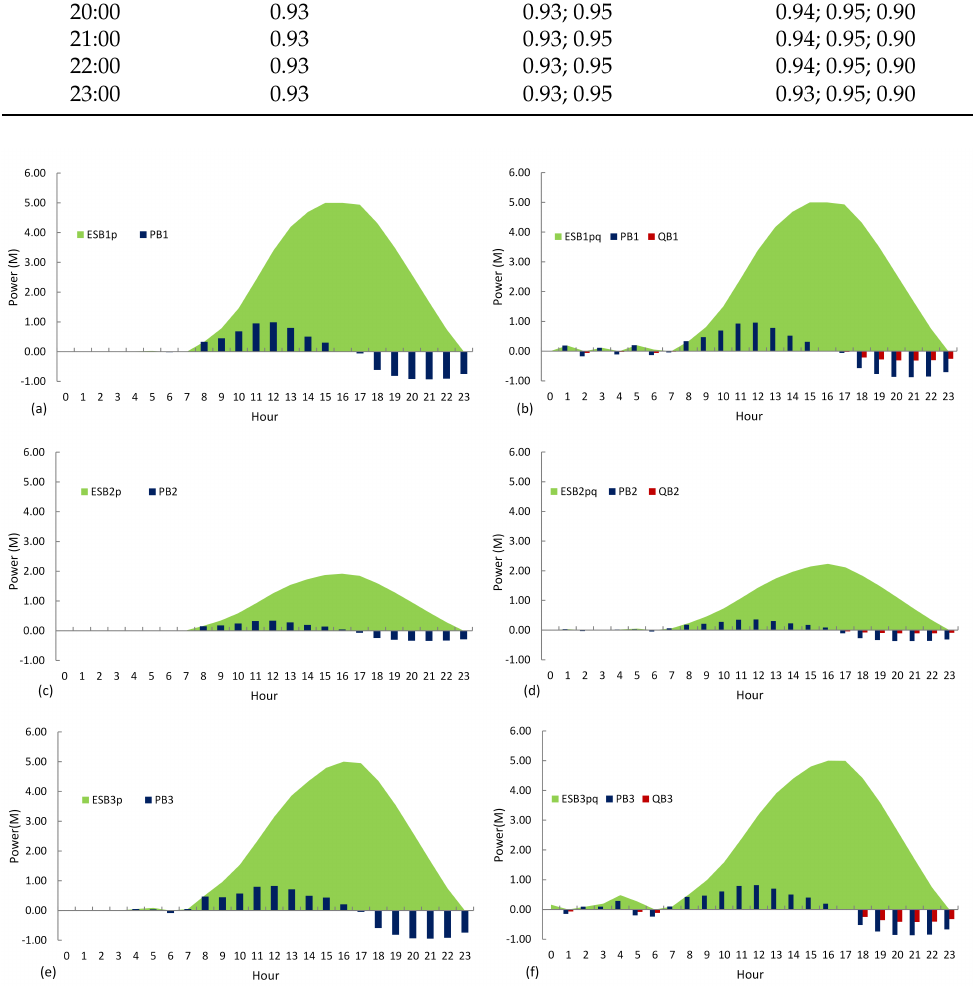
Figure 9. Power management for three BESS units: ( a ) active power BESS 1; ( b ) active and reactive power BESS 1; ( c ) active power BESS 2; ( d ) active and reactive power BESS 2; ( e ) active power BESS 3; ( f ) active and reactive power BESS